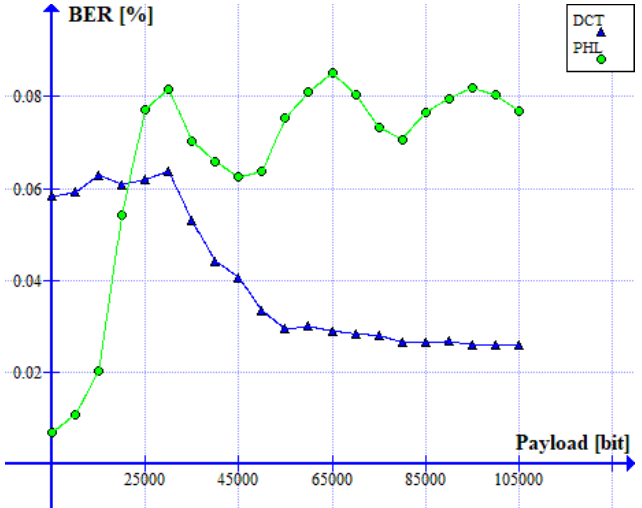
Figure 13. Relation between BER ratio and the watermark capacity (PHL vs.